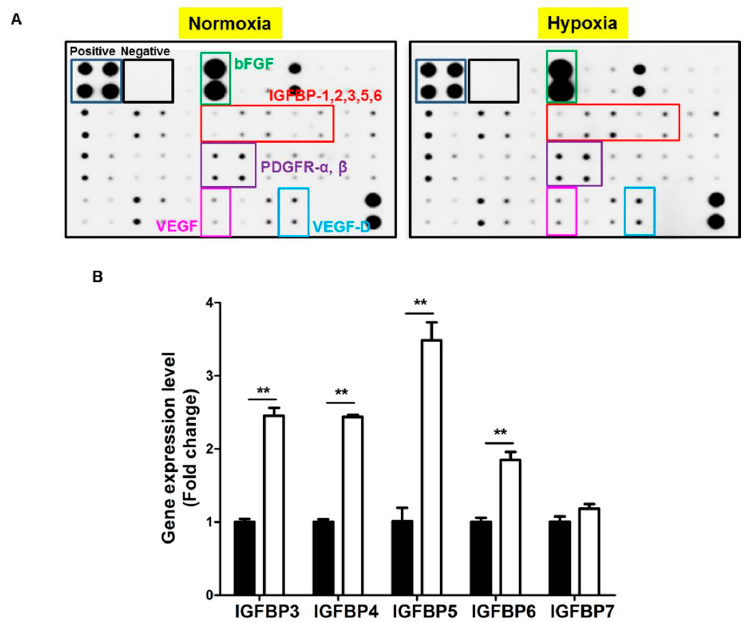
Figure 2. Hypoxia induces IGFBP expression. ( A ) The altered expression of growth factors was examined using an antibody array. Hypoxia (2%, 24 h) upregulated the protein expression of IGFBP families in ASCs; ( B ) the mRNA level of IGFBP families under hypoxia was measured. Hypoxia significantly upregulated IGFBP3–6. Normoxia: black bars, hypoxia: white bars. ** p < 0.01. Table 1. List of IGFs , IGF receptors and IGFBPs expression levels. Gene C t Value